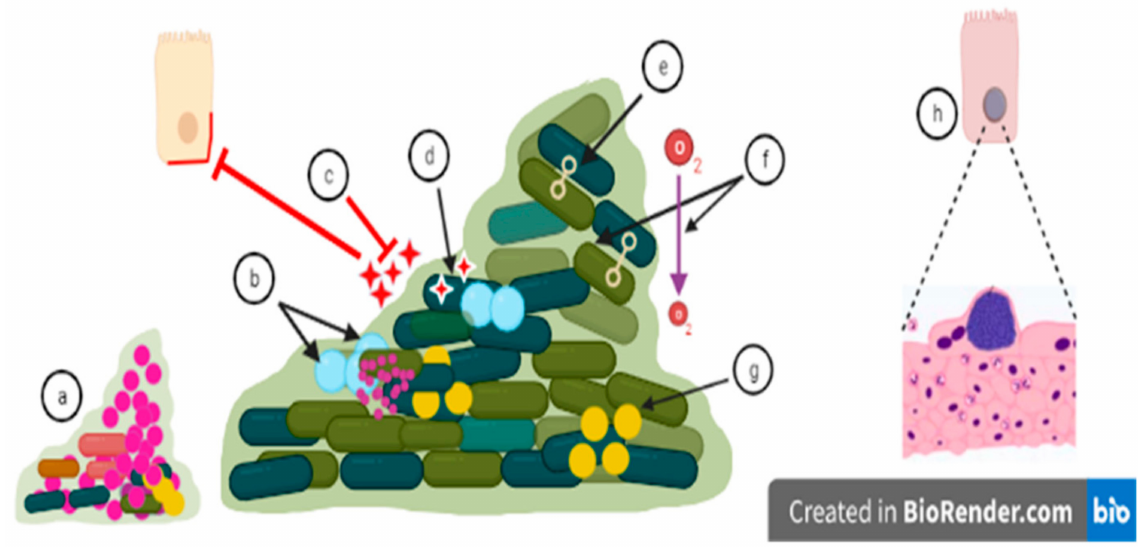
Figure 2. Biofilm related treatment challenges: (a) Small colony variants are mutants arising during chronic infections due to, for example, a defect in the heme biosynthesis pathway. Small colony vari- ants possess increased antibiotic resistance. (b) Growth rate is not uniform inside biofilm as persister cells are non-growing cells, and antibiotics may be inactive against these cells with low metabolic activity. (c) Antimicrobials fail to penetrate into the surface layer of biofilms or might be inactivated by extracellular matrix components, which decreases the effectiveness of antimicrobials. An increasing dose of the antimicrobial may lead to a cytotoxic effect on host cells [165]. (d) Antibiotics can be degraded or destroyed by enzymes which are secreted into the biofilm matrix. (e) Biofilm formation increases the effectiveness of genes transfer among the microbes constituting the biofilm [166]. Biofilm formation thus facilitates the transfer of antibiotic-resistant genes from resistant microbial strains to susceptible microbial strains. (f) pH and oxygen levels are different in different microenviron- ments of the biofilm which aid the defensive mechanisms of biofilm and can prevent uptake of antimicrobial agents. (g) Microbial cells communicate through quorum sensing which can trigger increased virulence and biofilm formation by altered gene expression, and accelerating the process of antibiotic tolerance [167]. This mechanism can stimulate biofilm formation, but also disperse biofilms depending on the autoinducer molecule. (h) Intracellular biofilm as, for example, observed in the murine cystitis model. After microbial invasion, these biofilm-like intracellular bacterial communities replicate and persist in host cells, protected from antimicrobial action and can subsequently disperse to other host cells